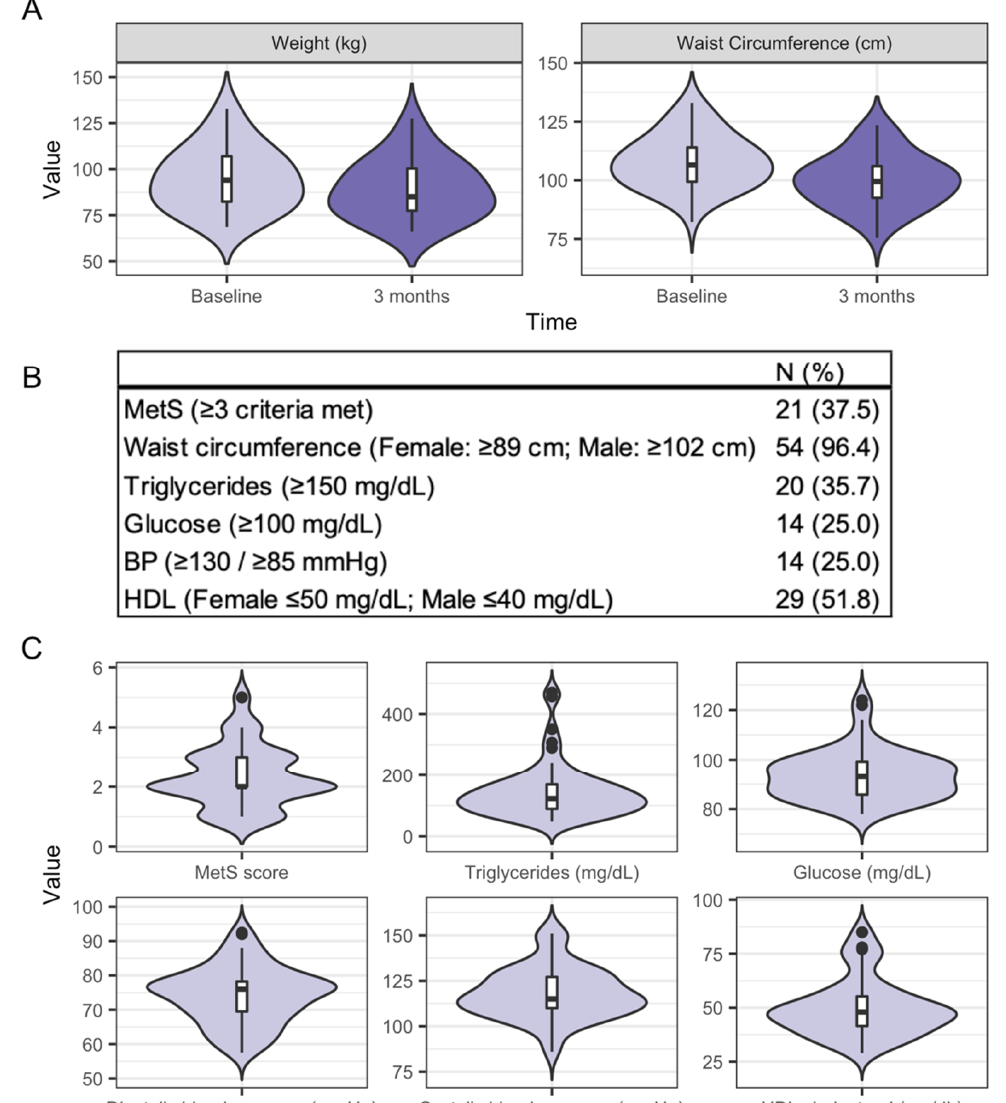
Figure 2. Clinical characteristics of DRIFT2 participants. ( A ) From baseline to three months of the intervention, participants ( n = 59) lost significant weight and waist circumference as shown in these violin plots. ( B ) Blood-based clinical health measures for DRIFT2 participants were assessed at baseline but not at three months. This tables shows the number of participants meeting each of the criteria for metabolic syndrome (MetS) at baseline ( n = 56). ( C ) These violin plots show the distribution of metabolic syndrome (MetS) score ( n = 56), which is the total number of components that define MetS that exceed the thresholds shown in ( B ), and of the components of MetS. BP: blood pressure; MetS: metabolic syndrome; HDL: high density